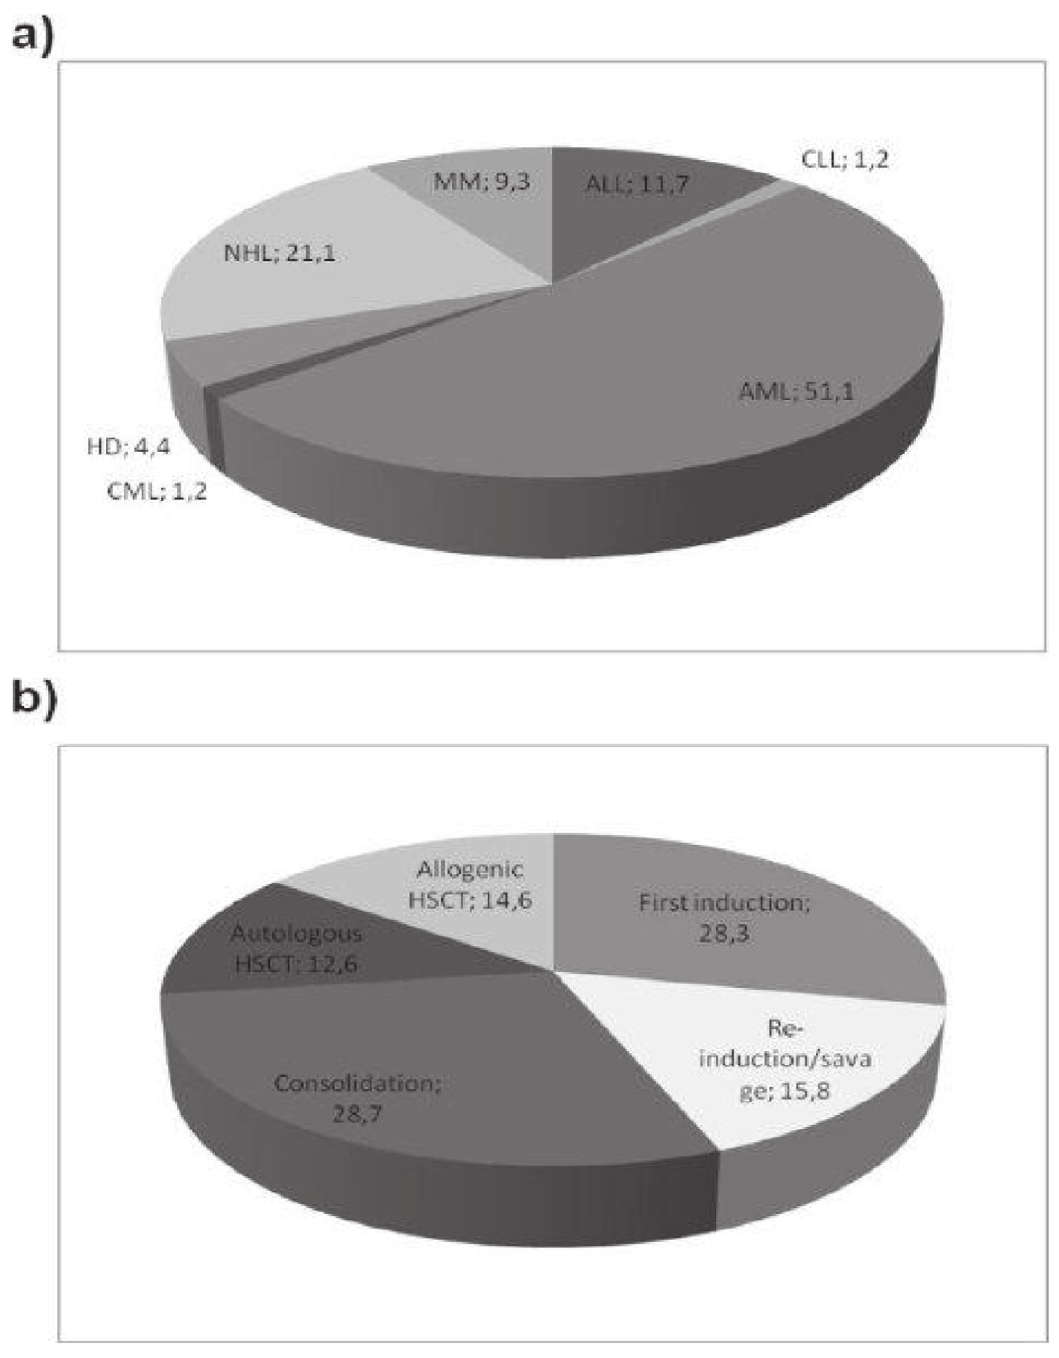
Figure 1. Distribution (%) of a) type of hematological malignancies and b) stages of disease in the derivation and validation sets. AML, acute myeloid leukemia; ALL, acute lymphoid leukemia; NHL, lymphoma; HD, Hodgkin’s disease; CML, chronic myeloid leukemia; MM, multiple myeloma; CLL, chronic lymphocytic leukemia; BMT, bone marrow transplantation.